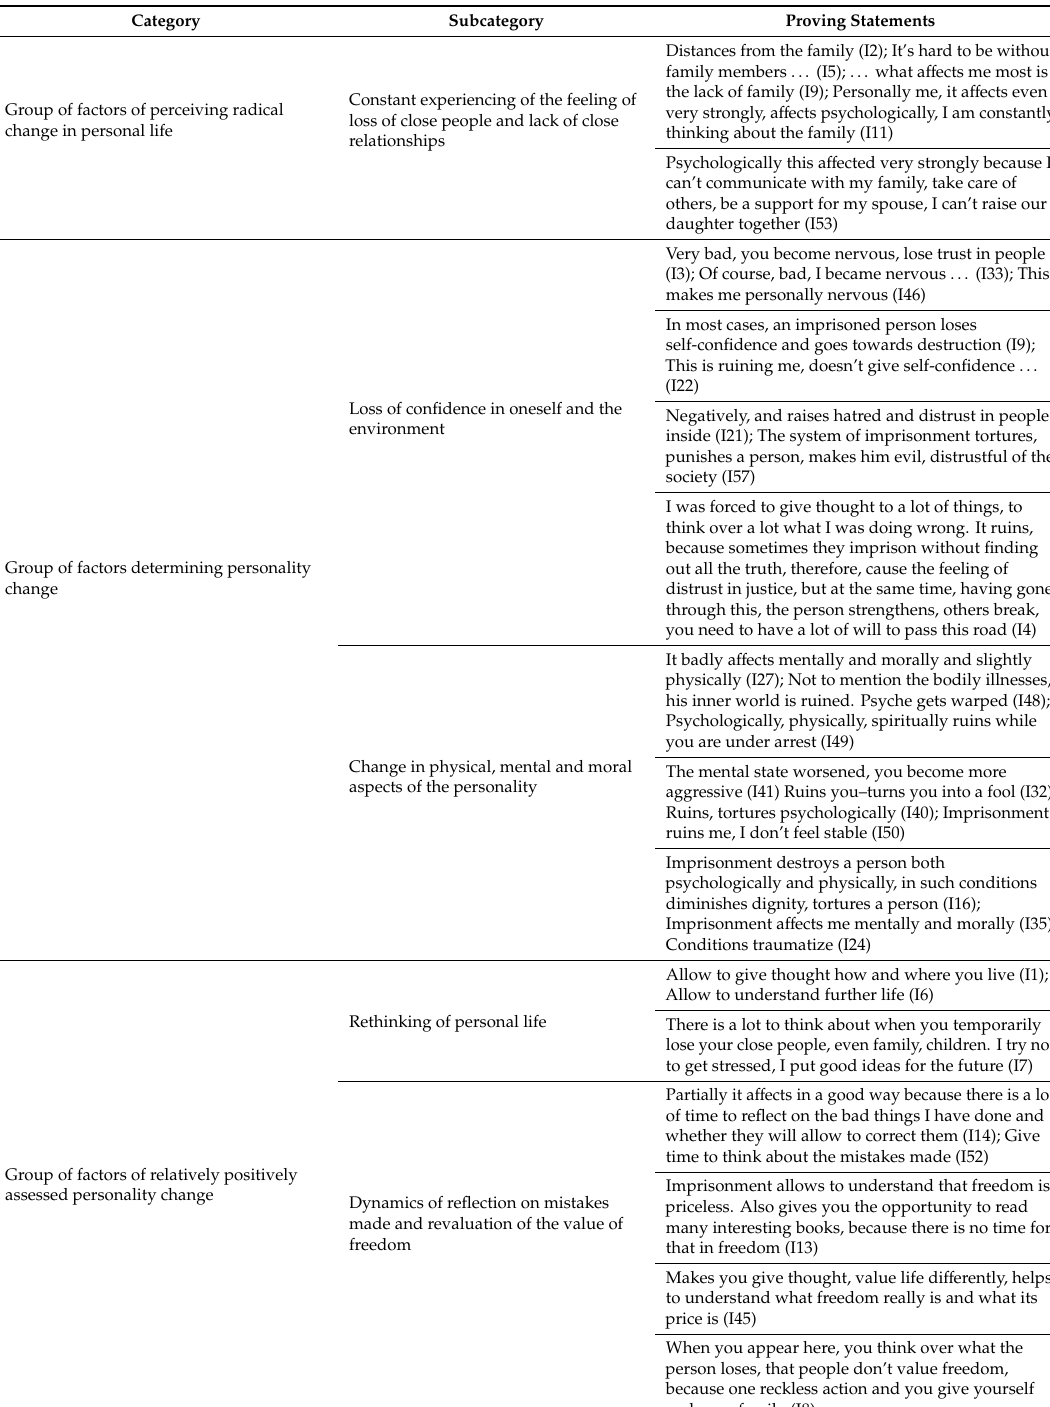
Table 2. Identification of incarceration as a punitive measure transforming and separating the